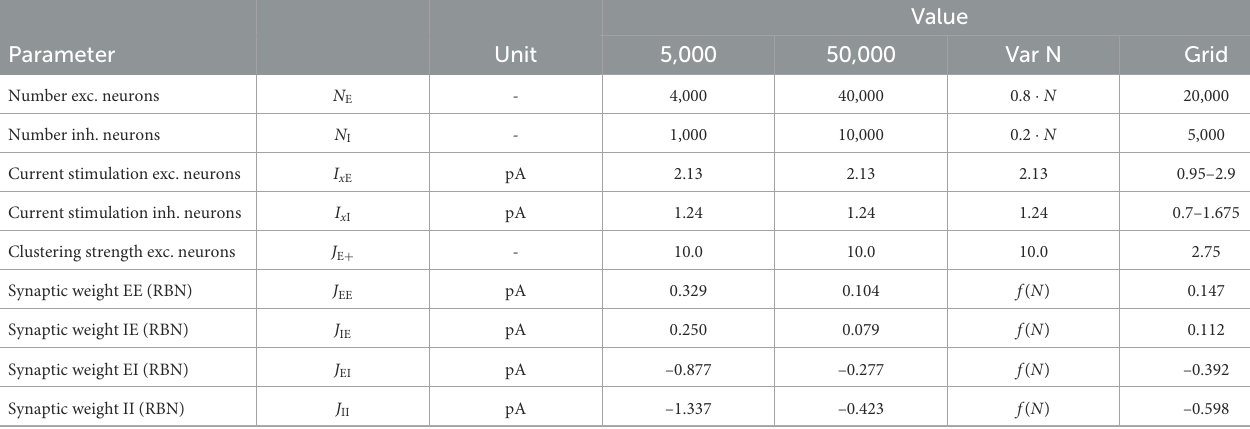
TABLE 7 Variable model parameters for different simulation